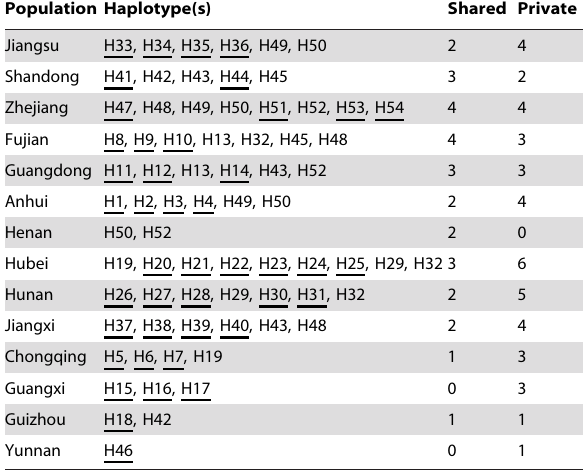
Table 2. Haplotype distribution and the number of shared and private haplotypes (underlined) in the 14 populations of M. alternatus